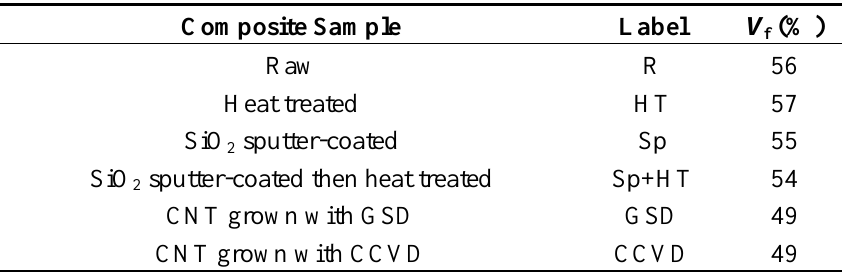
Table 1. Fiber volume fractions for the specimens based on raw PAN-based carbon fabric (Raw), SiO sputter-coated fabric (Sp), heat-treated fabric (HT), SiO 2 heat-treated fabric (Sp + HT) and with CNTs grown on their surfaces via graphitic structures by design (GSD) and catalytic chemical vapor deposition (CCVD).